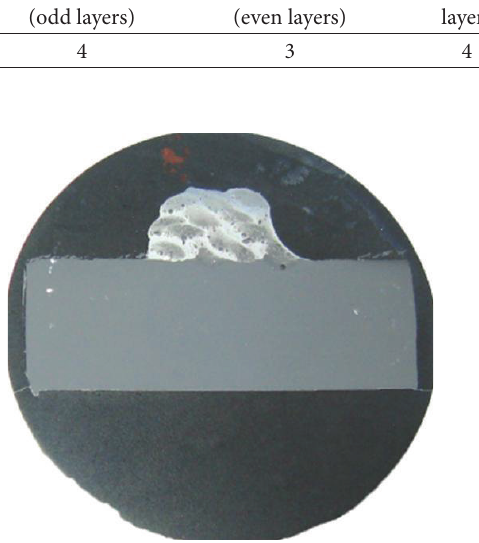
Figure 5: Sample section